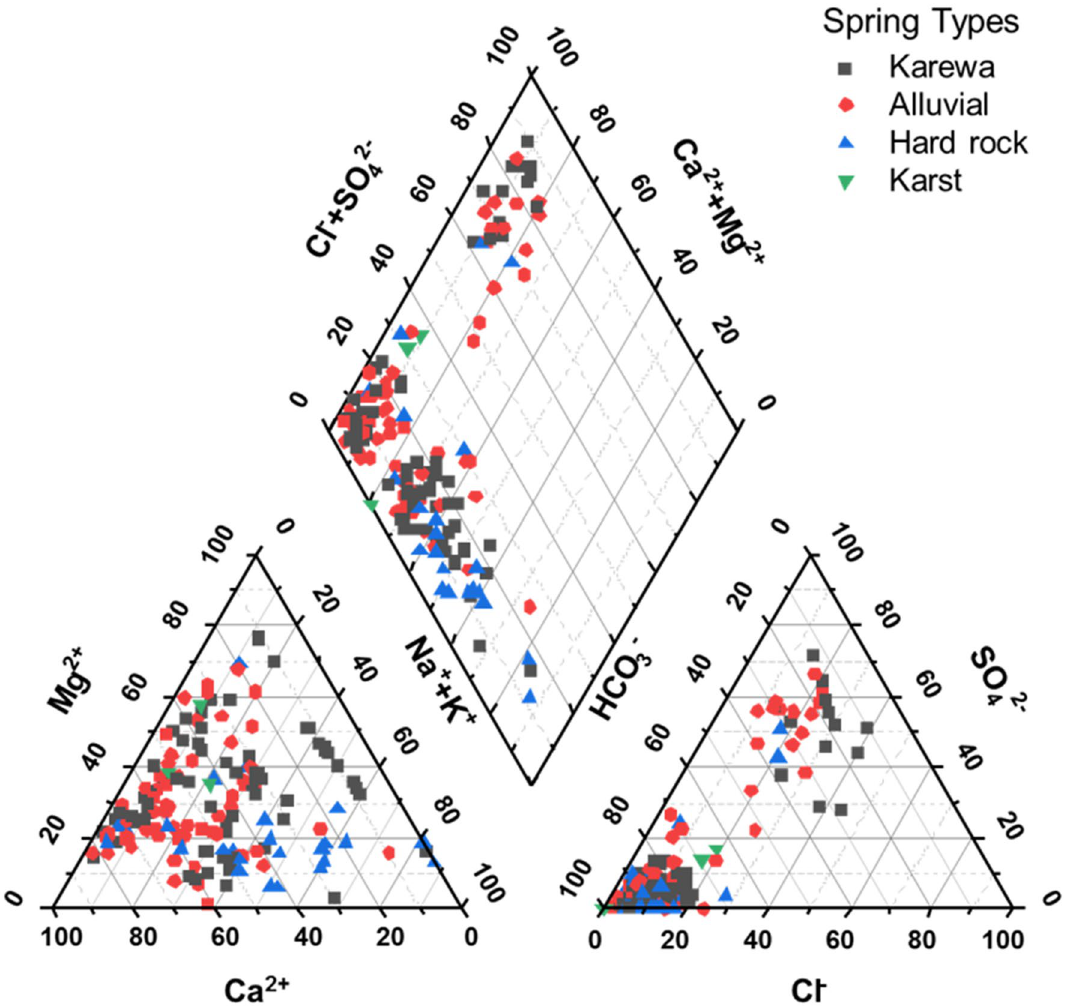
Figure 3. Piper trilinear diagram of the major cations and anions of the springs. This figure was plotted using R programming for statistical computing (https:// cran.r- proje ct. org/ bin/ windo ws/